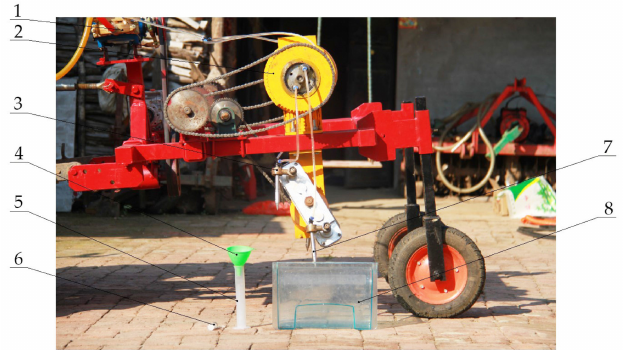
Figure 10. Test device. 1. Liquid fertilizer pump; 2. Distribution device; 3. Cavity tying mechanism; 4. Funnel; 5. Measuring cylinder; 6. Syringe; 7. Fertilizer injecting needle; 8. Fertilizer measuring